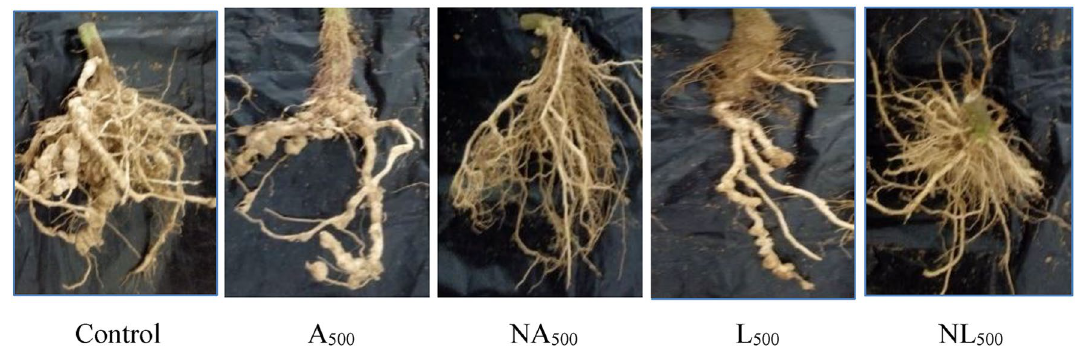
Figure 3. Root galls in M. incognita infected tomato